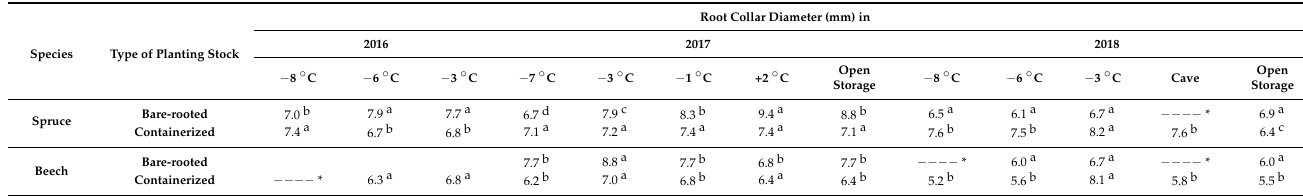
Table 4. Average root collar diameters of Norway spruce and European beech in storage treatments at the end of the first growing season in three years of the research (different letters in the exponent (a, b, c) denote significant differences between storage treatments within each tree species and type of planting stock in every year of the